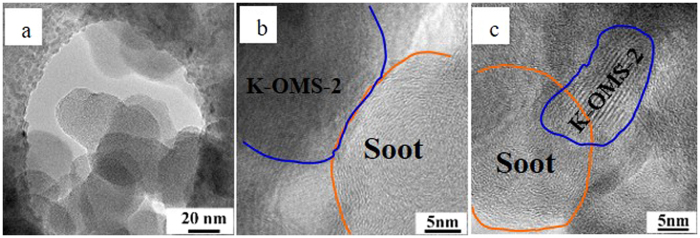
TEM (a), and HRTEM (b,c), images of 3DOM K-OMS-2/SiO2-50 and soot complex. TEM image are obtained at the temperature 280 °C, reaction conditions: 10% O2, 2000 ppm NO, Ar balance gas, total gas flow: 50 mL/min.